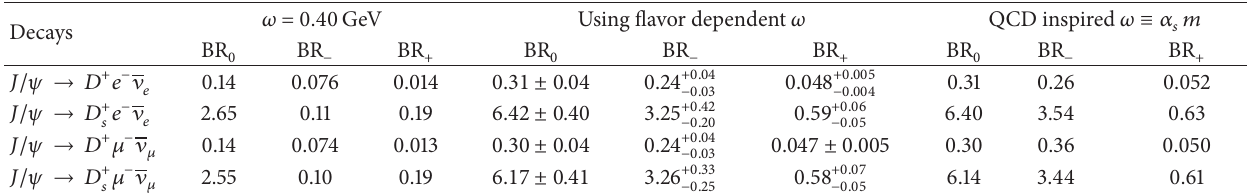
Table 3: Branching ratios BR 0 , BR − , and BR + corresponding to the Helicity amplitudes 𝐻 0 and 𝐻 ±1 (in the units of 10 −10 ) of 𝐽/𝜓 → 𝑃𝑙𝜈